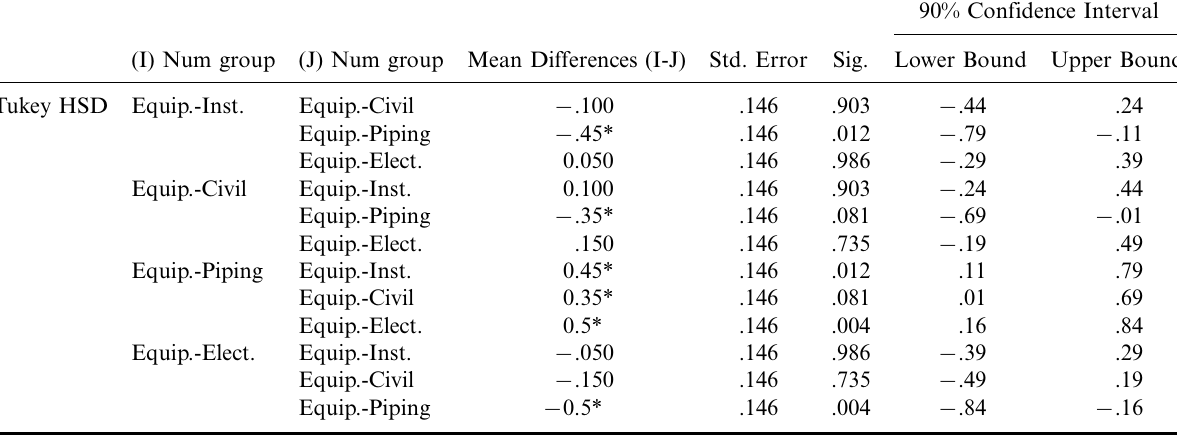
Sig. Lower Bound Upper